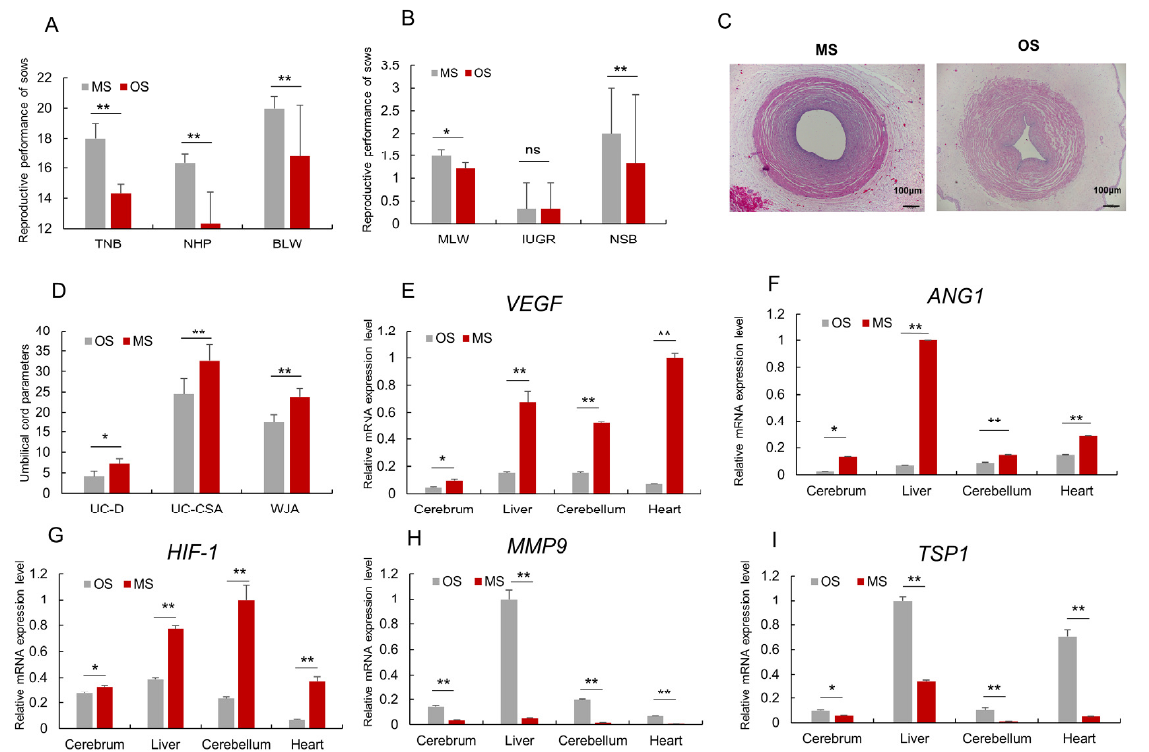
Figure 2. Angiogenesis of OS pig was repressed. ( A , B ) Reproductive performance of OS and MS sows; ( C ) The morphological characteristics of Umbilical Cord, 40×, scale = 100 µm. umbilical vein of MS; umbilical vein of OS; ( D ) Umbilical vein diameter (UV-D), Umbilical vein cross-sectional area (UV-CSA), Wharton’s jelly (WJA); ( E – G ) mRNA relative expression level of pro-angiogenesis genes (VEGF, ANG1, HIF-1 ) in both MS and OS piglet’s tissues; ( H , I ) mRNA relative expression level of angiogenesis inhibiting genes ( MMP9, TSP1 ) in both MS and OS piglet’s tissues. * or ** represents significance at the 0.05 or 0.01 level, respectively, and ns represents no significance.